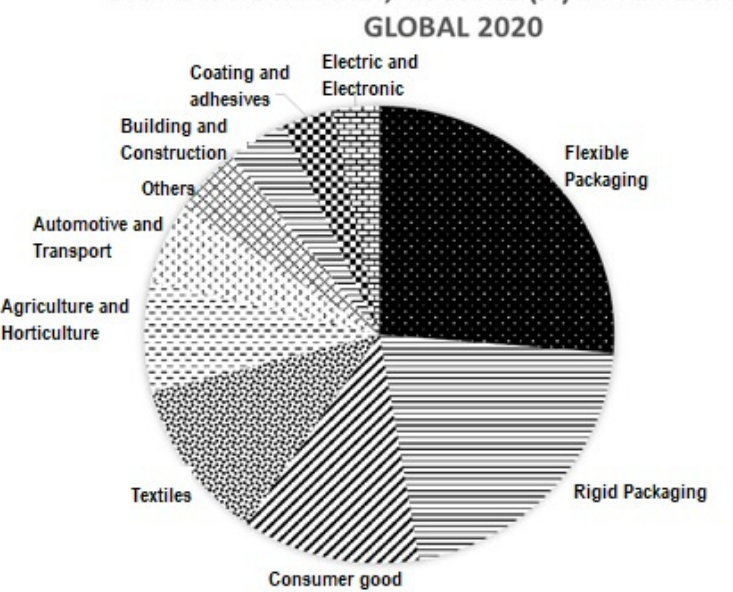
Figure 5. Composition of bioplastic market worldwide, 2020. Data adapted from